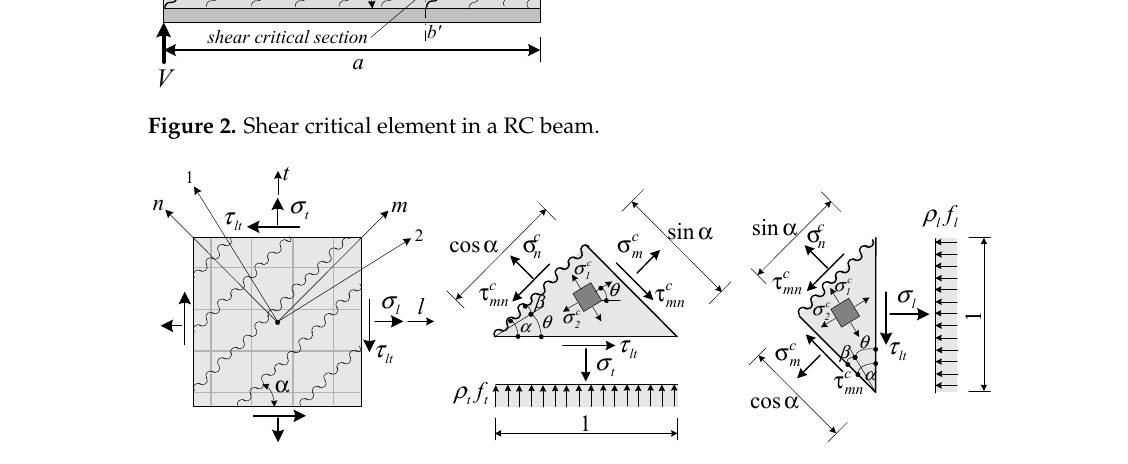
Figure 3. Stress states and coordinates of shear critical element. Table 1. Equilibrium and compatibility equations used in shear analytical model [16].